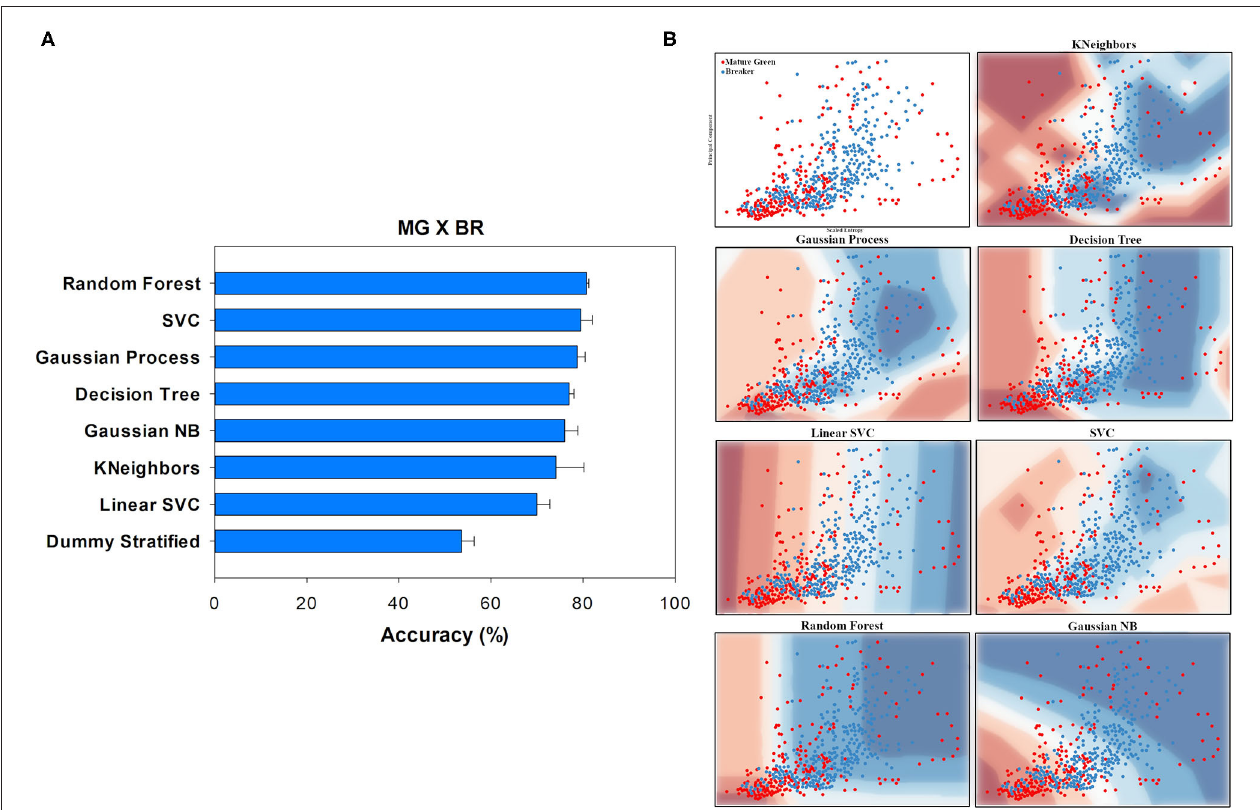
FIGURE 4 | Accuracy (%) and standard deviation (A) of the Machine Learning models used to classify Mature Green (MG) and Breaker (BR) classes. Scatter plots (B) showing a sample space plan used in ML training for the MG × BR distribution. Red dots: MG; blue dots: BR. The regions are the demarcations made by ML to indicate levels of certainty of classification. The more reddish it is, the more certain it belongs to the MG group. The more bluish it is, the more certain it belongs to the BR group. The subtitle of each graph indicates the method used. On the y -axis is the data from PCA1. On the x -axis is the distribution of the Scaled Entropy.